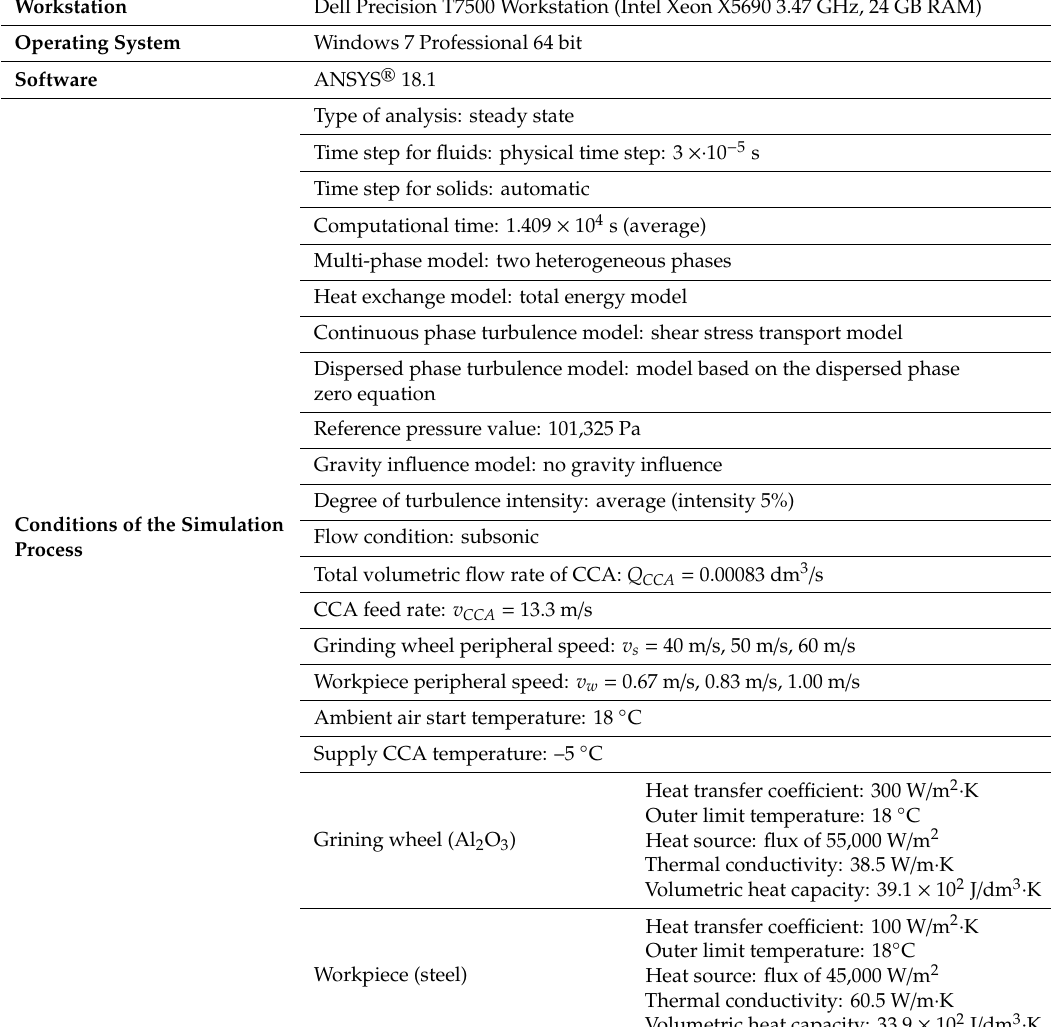
Table 5. Conditions of simulation